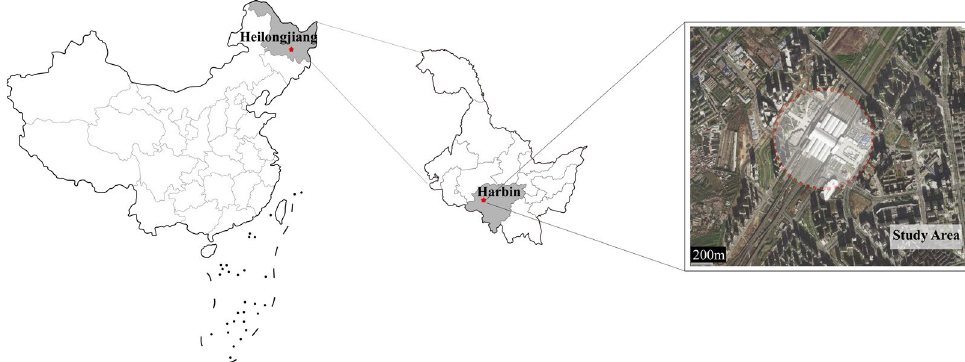
Figure 1. The location of the study